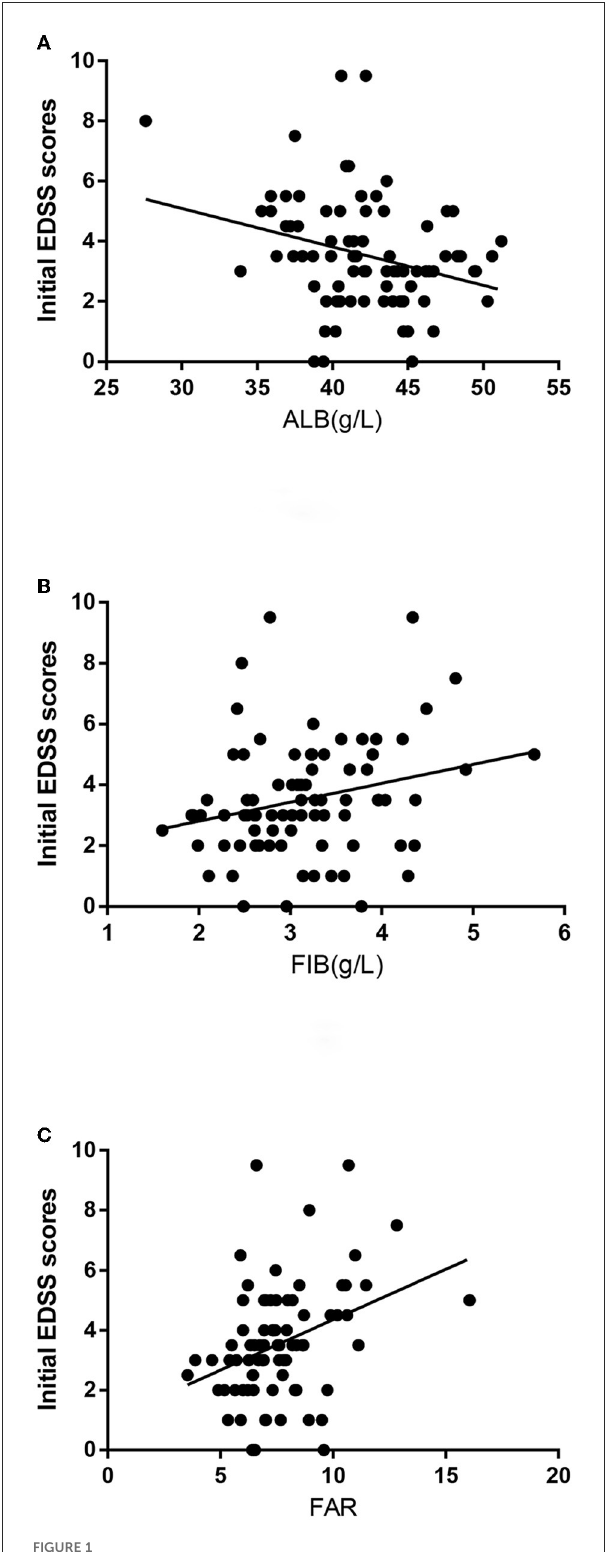
FIGURE1 (A) The correlation between albumin (ALB) levels and the initial expanded disability status scale (EDSS) scores is shown. (B) The correlation between fibrinogen (FIB) levels and the initial EDSS scores is shown. (C) The correlation between FIB-to-ALB ratio (FAR) levels and the initial EDSS scores is shown.